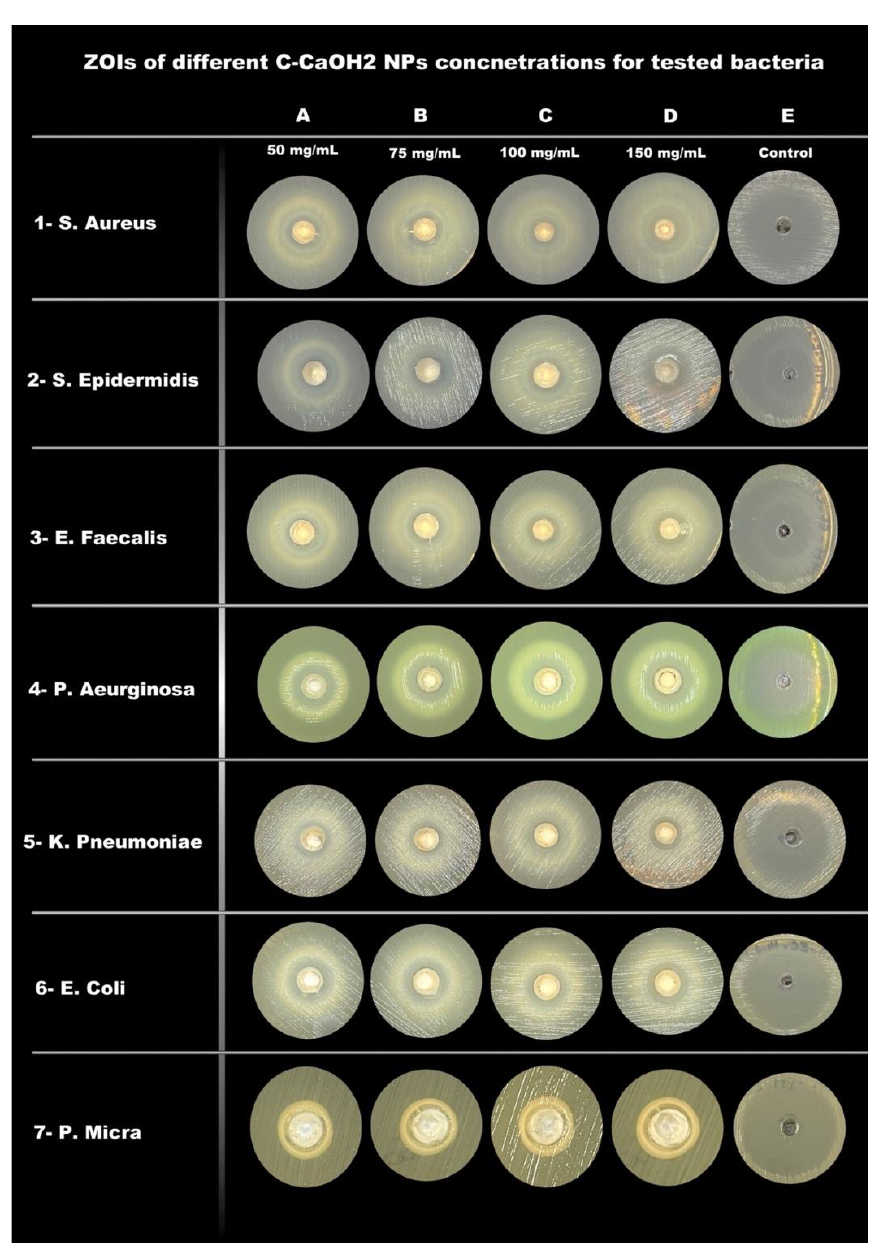
Figure 1. Agar well diffusion with the different C-CaOH 2 NPs concentrations against aerobic and anaerobic strains. The diffusion of C-CaOH 2 NPs displayed a white halo surrounding the inhibition zones. A: 50 mg/mL C-CaOH 2 NPs concentration showed the least ZOI activity. The difference in ZOI between B: 75 mg/mL C-CaOH 2 NPs concentration, and C: 100 mg/mL C-CaOH 2 NPs concentration was not significant, however, dose-dependent increase in zones observed. D: 150 mg/mL C-CaOH 2 NPs concentration showed the greatest ZOI. Compared to E: ciprofloxacin control, C-CaOH 2 NPs exhibited intermediate ZOI activity.